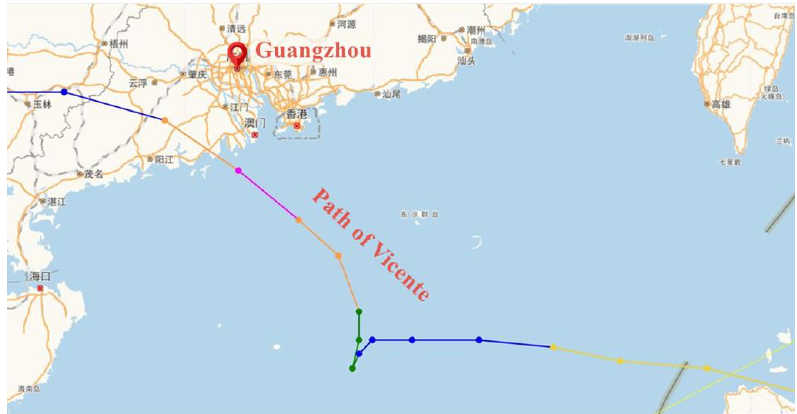
Figure 3. Path of Typhoon Vicente.